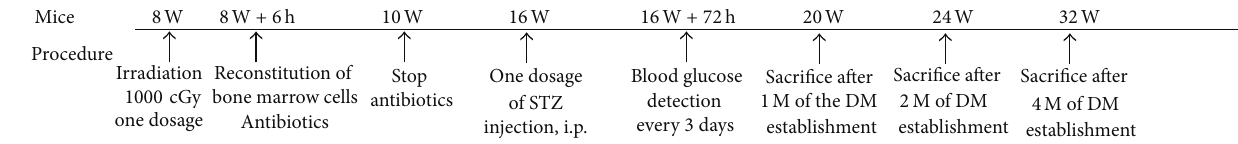
Figure 1: The study flow chart of the whole